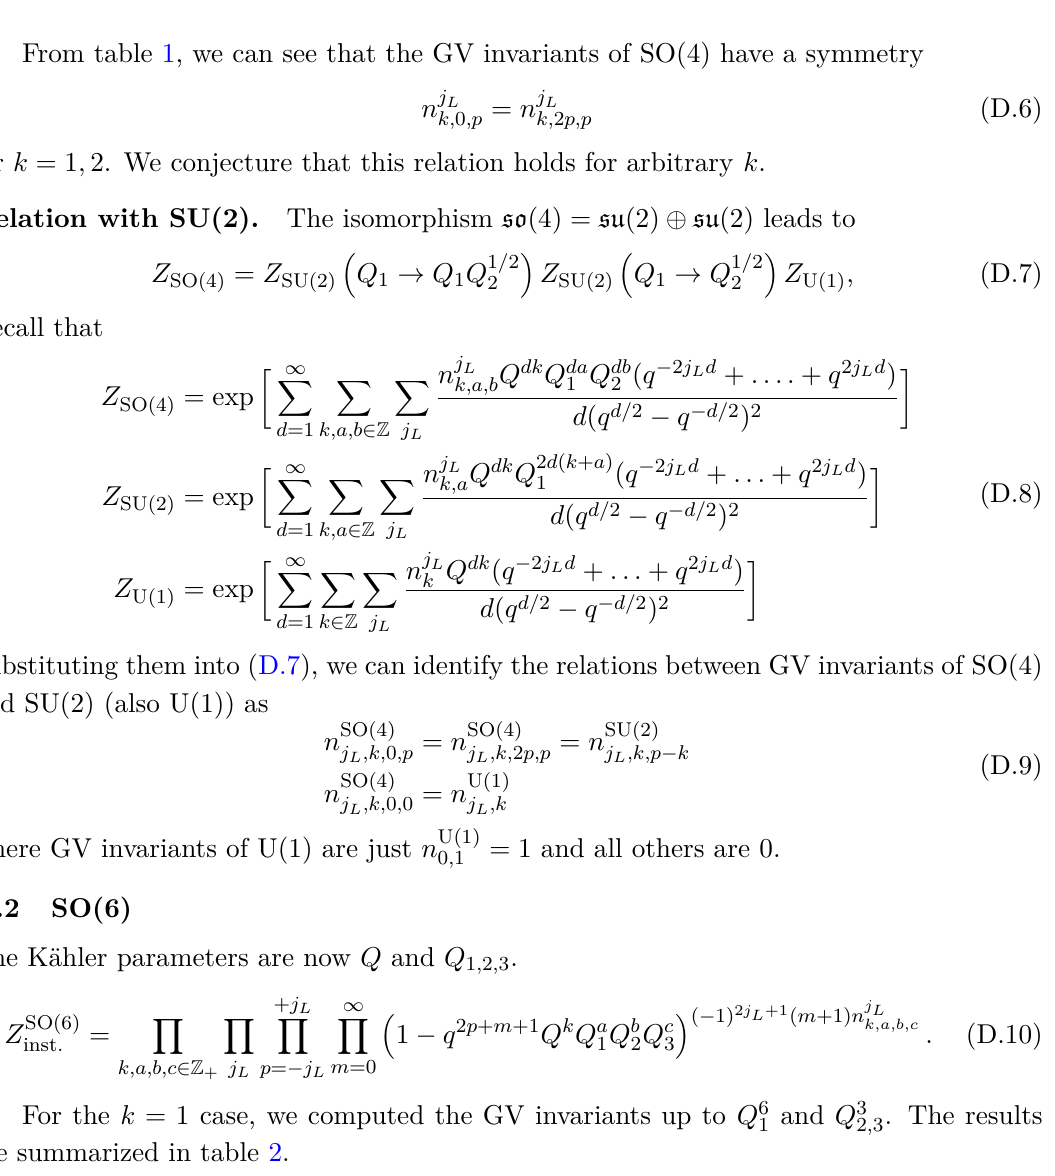
for SO(4) , k = 2 2 ,a,b